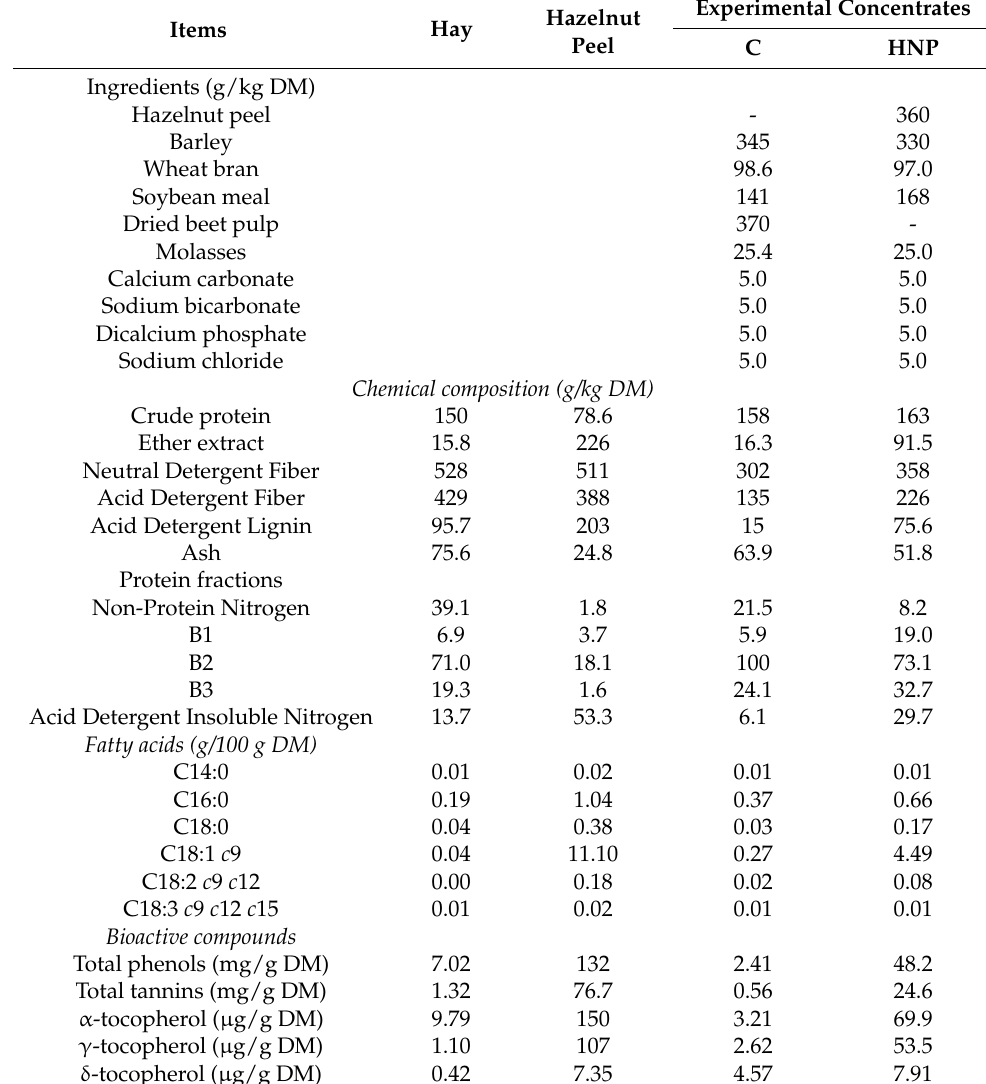
Table 1. Ingredients, chemical composition, fatty acids, and bioactive compounds of diets used in the experiment, including concentrates containing either beet pulp (C) or hazelnut peel (HNP). Hazelnut Items Hay